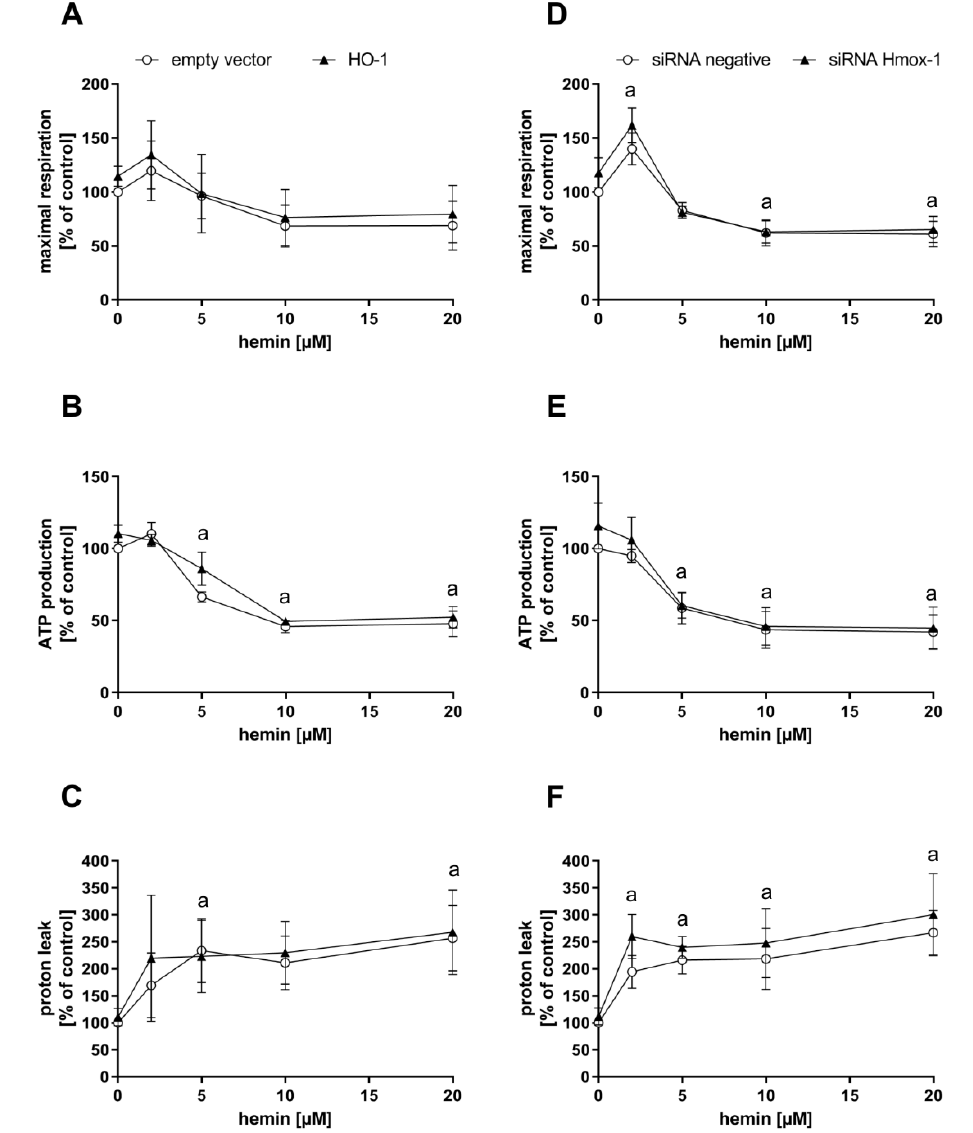
Figure 3. Hemin treatment of cells leads to an effect pattern of mitochondrial respiratory parameters comparable to CO. Heme oxygenase-1 protein levels of MEFs were genetically modified by either overexpression (left panel) or knockdown using siRNA (right panel). Cells were then treated with 2–20 µ M hemin for 4 h and subjected to the mito stress test. Quantifications of the mitochondrial respiratory parameters maximal respiration ( A , D ), ATP production ( B , E ), and proton leak ( C , F ) are given. Data represent the mean ± SD of three independent experiments (n = 3). Statistical analysis was performed using one-way ANOVA and detailed results are given in Table S2. a: control vs. treatment with p ≤0.05.